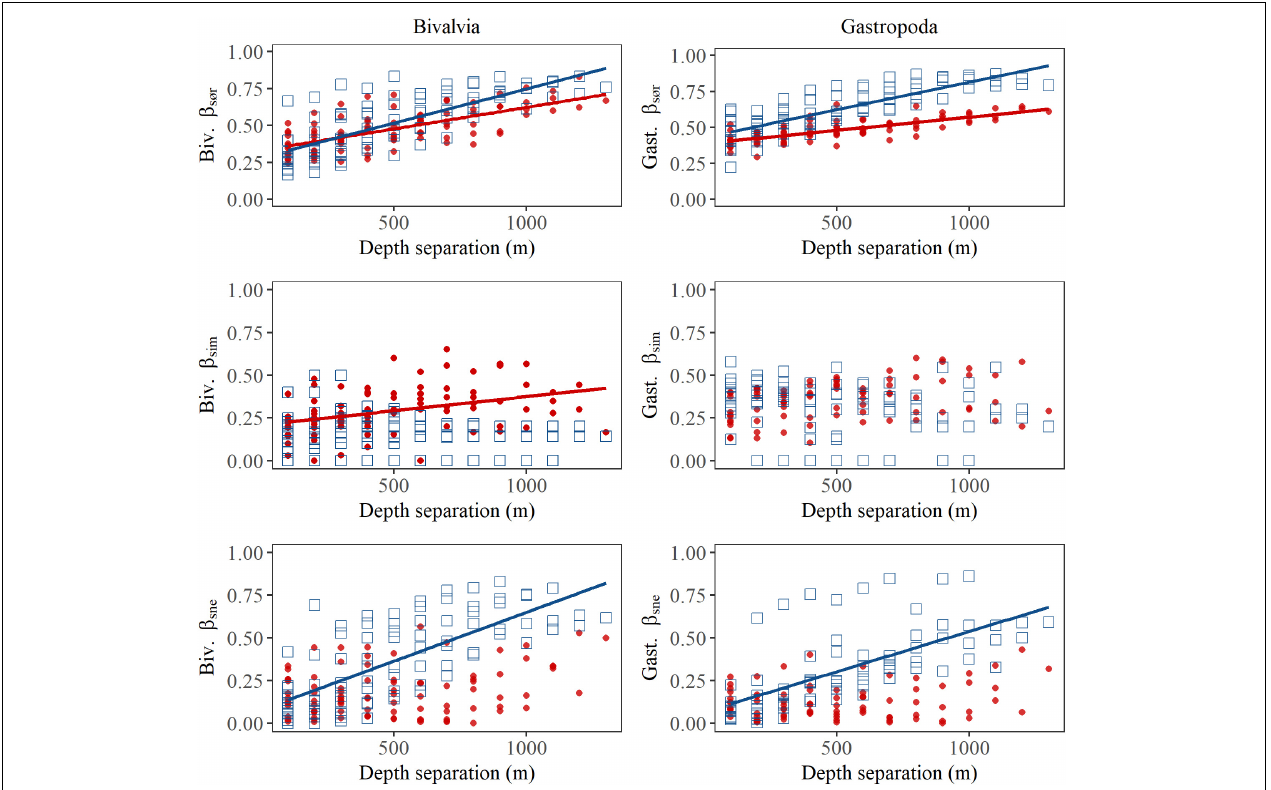
FIGURE 5 | Pairwise dissimilarity of bivalve (left) and gastropod (right) assemblages as a function of depth separation among depth bins in the Iceland Sea north of the GIF ridge (blue square) and south of the GIF ridge (red points). Pairwise overall β -diversity, or β sør is partitioned into β sim or dissimilarity resulting from species replacement and β sne or dissimilarity resulting from nestedness or species loss (or gain). Regression lines indicate where least square linear regression resulted in a p < 0.001 for the slope.